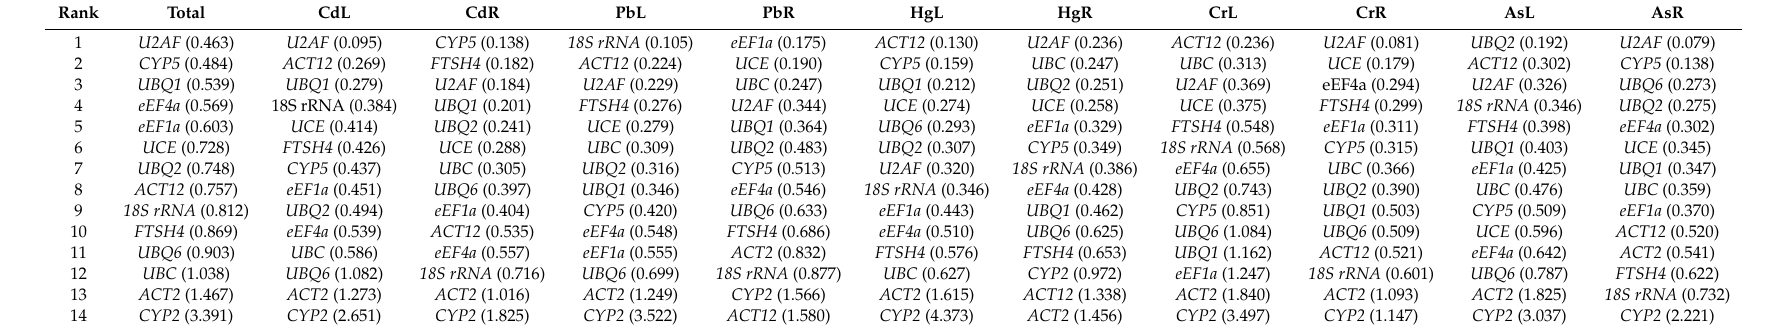
Table 2. Expression stability values for switchgrass candidate reference genes calculated by NormFinder.